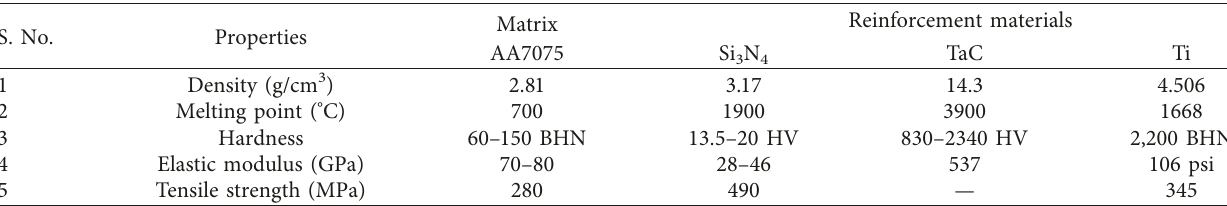
Table 2: Properties of matrix and reinforcing phase.